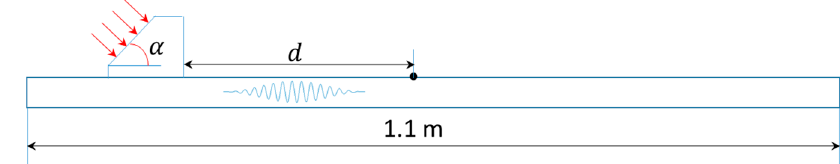
Figure 2. Schematic of 2-D plane strain simulation model for the mode pairs S 0 -S 0 and S 1 -S 2 .